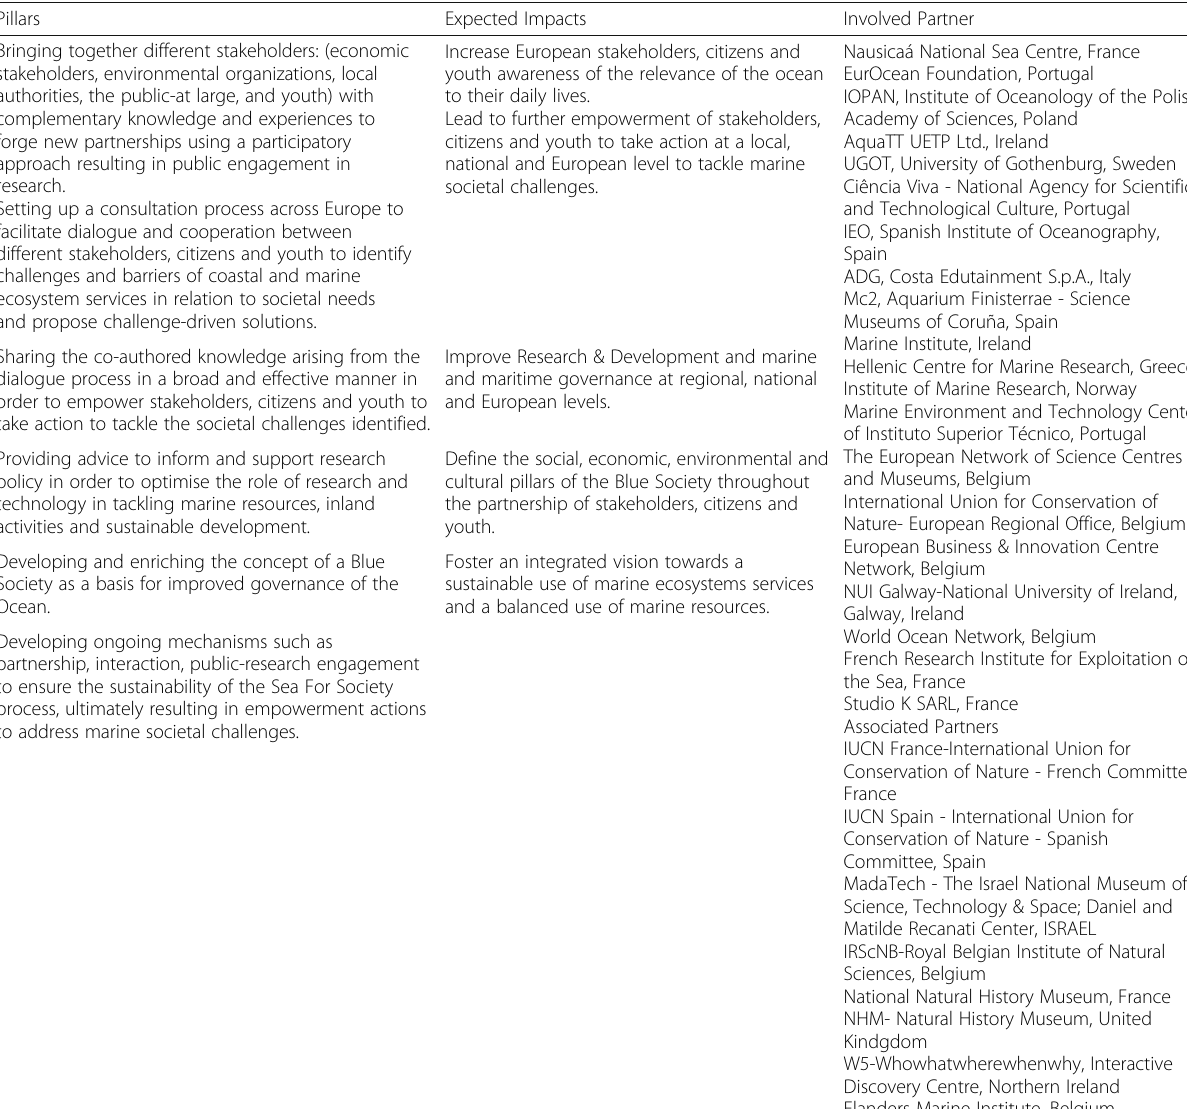
Table 6 The Sea For Society project Pillars Expected